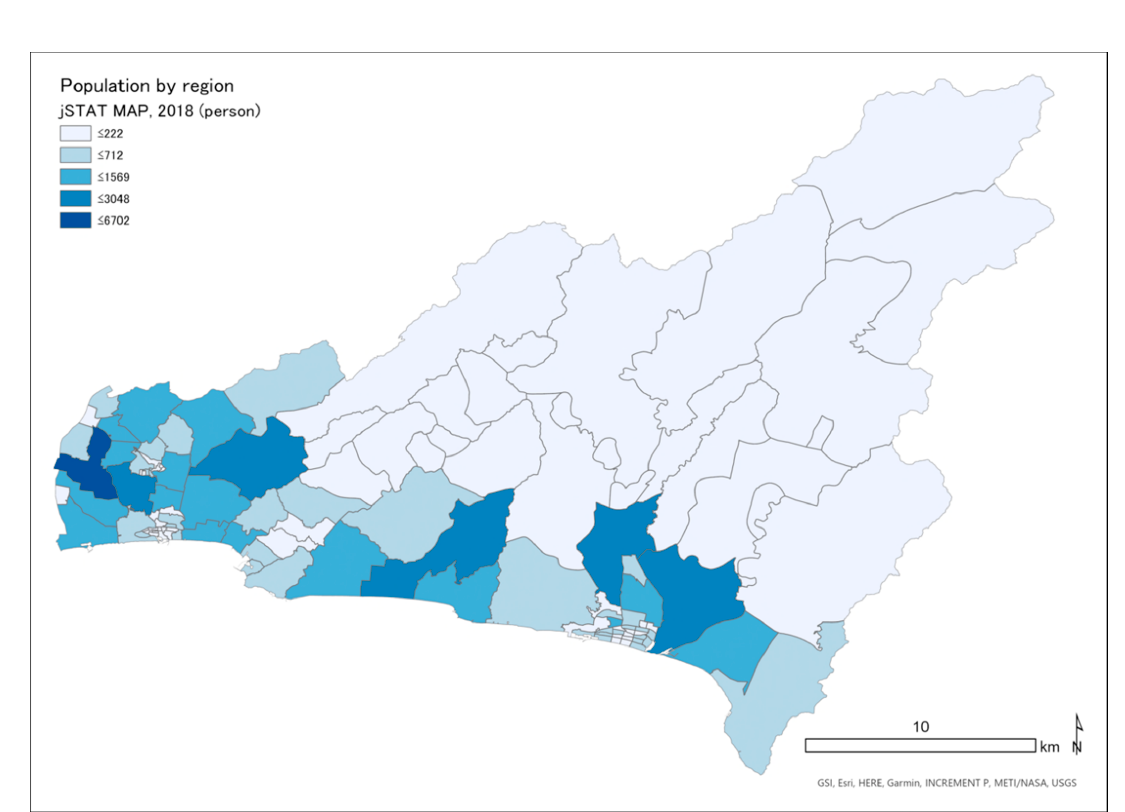
Figure 2. Population distribution by region in Konan, Geisei, and Aki.